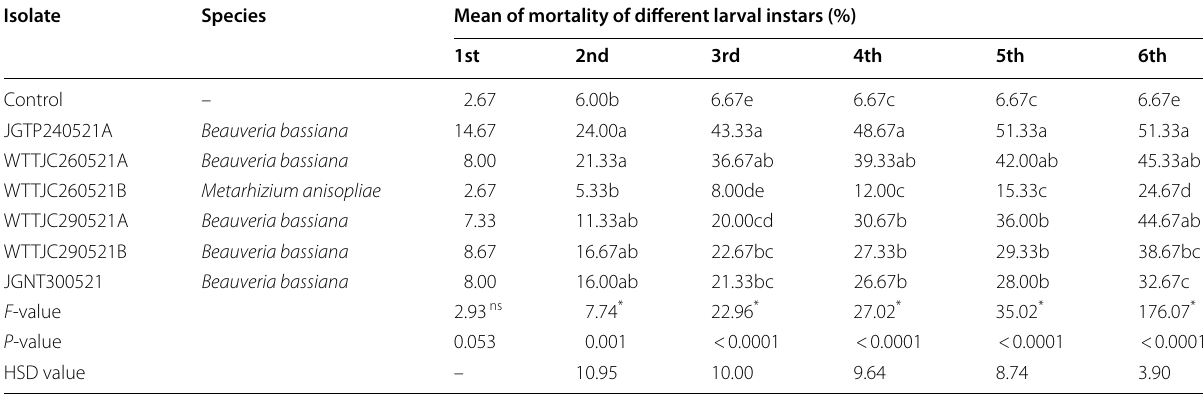
ns not significantly different * significantly different; values within a column followed by the same letters were not significantly different at P < 0.05 according to = = Tukey’s HSD test